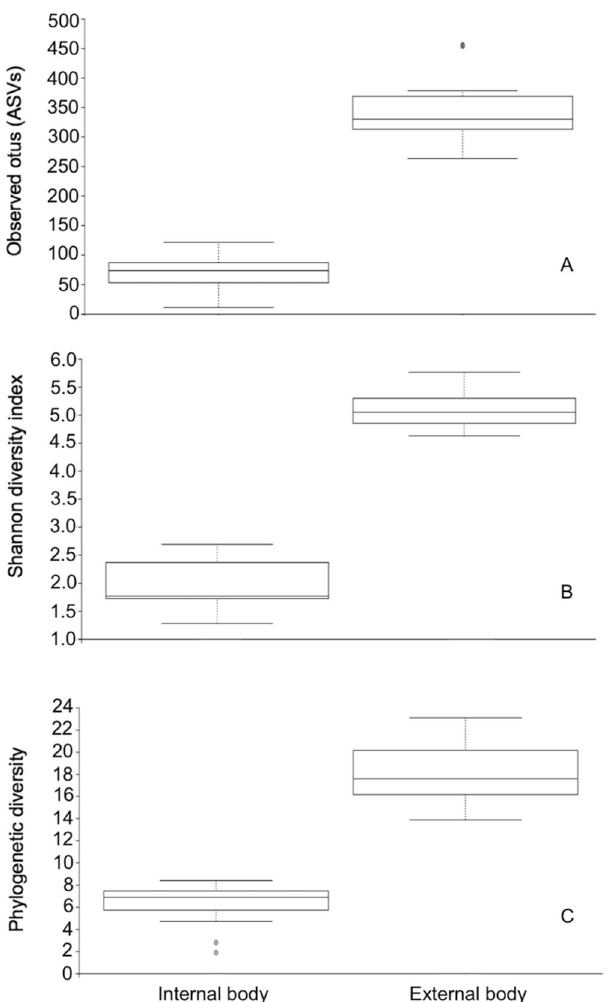
Figure 2. Alpha diversity measures of the internal (endogenous) and external body (exogenous) microbiomes of adult black blow flies. ( A) Observed OTUs, ( B) Shannon diversity and ( C) Faith’s phylogenetic